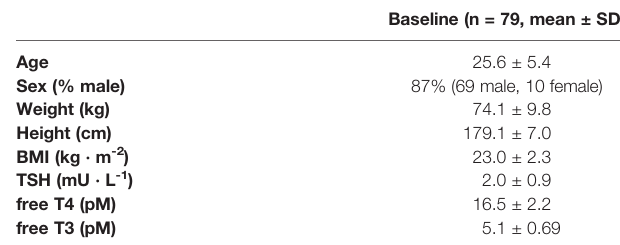
TABLE 1 | Clinical characteristics at